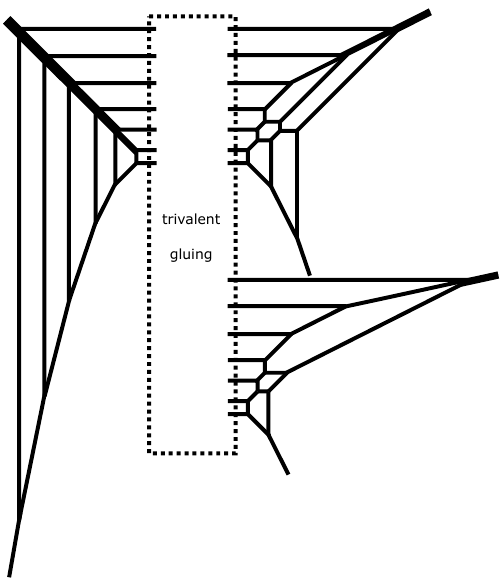
Figure 55. The web diagram of the theory obtained after the Higgsing (6 , 3 , 2)